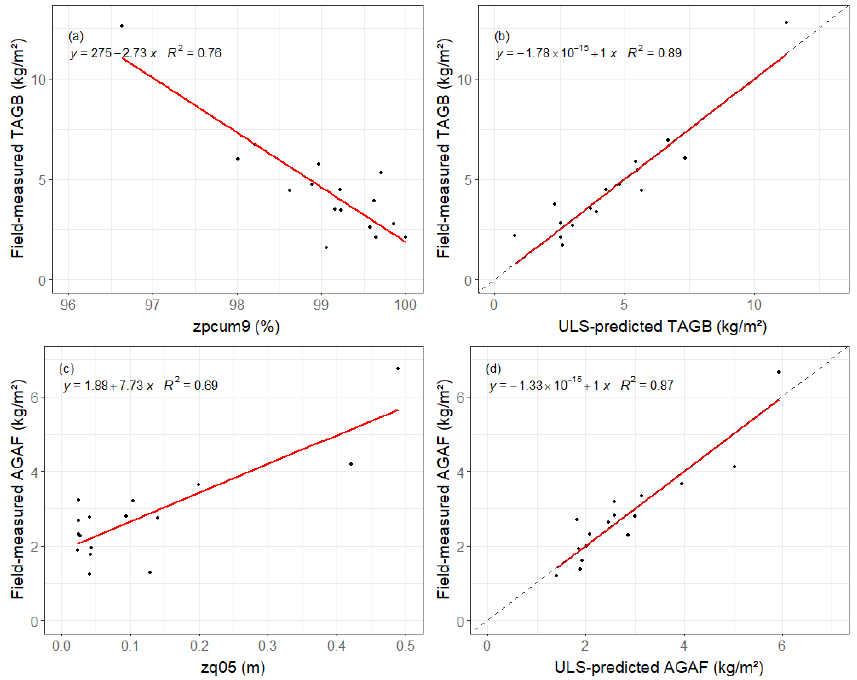
Figure 6. Performance of the lidar and field-measured metrics in predicting ( a ) TAGB and ( b ) AGAF, coloured by the type of predictor variable.